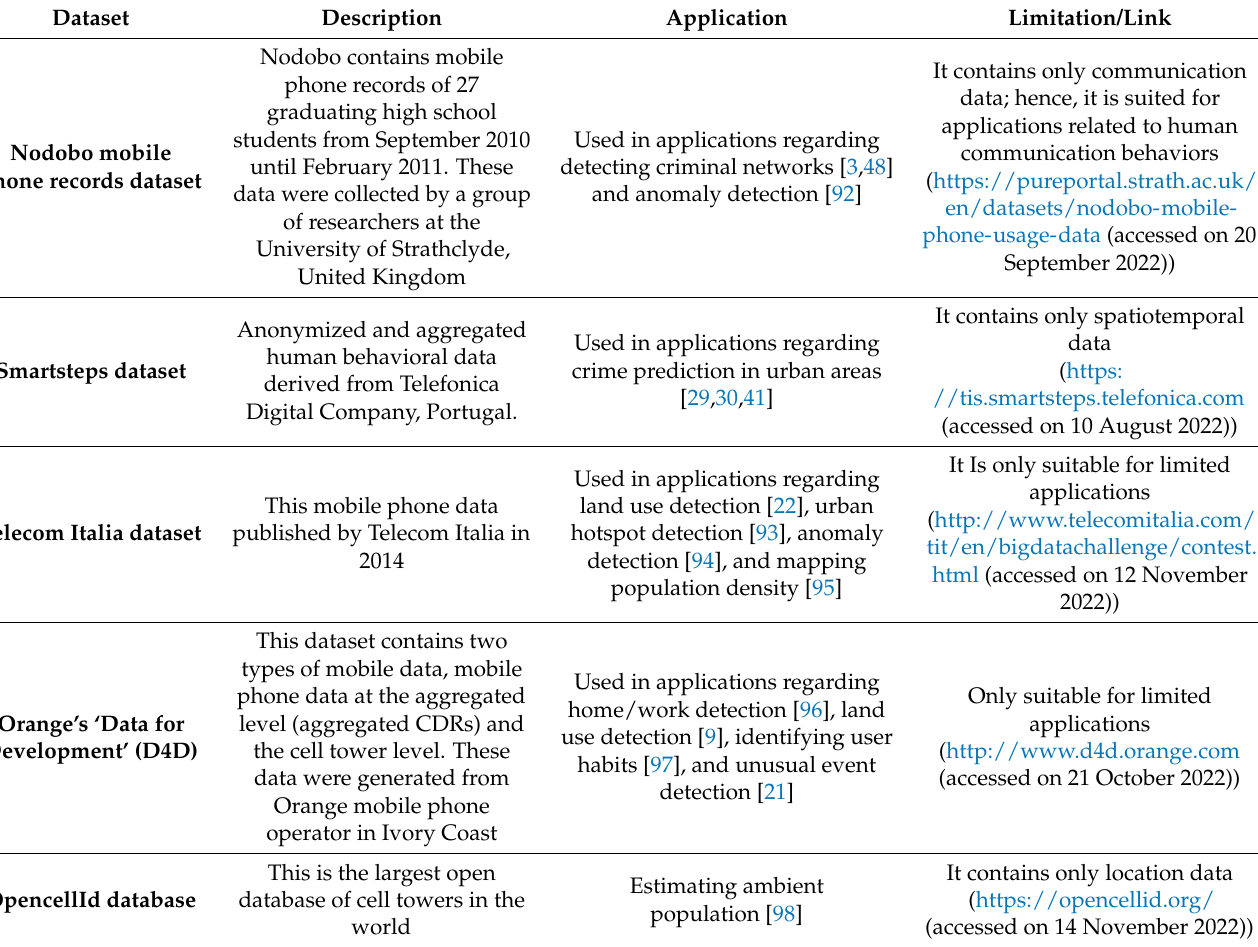
Table 6. List of publicly available datasets used in the